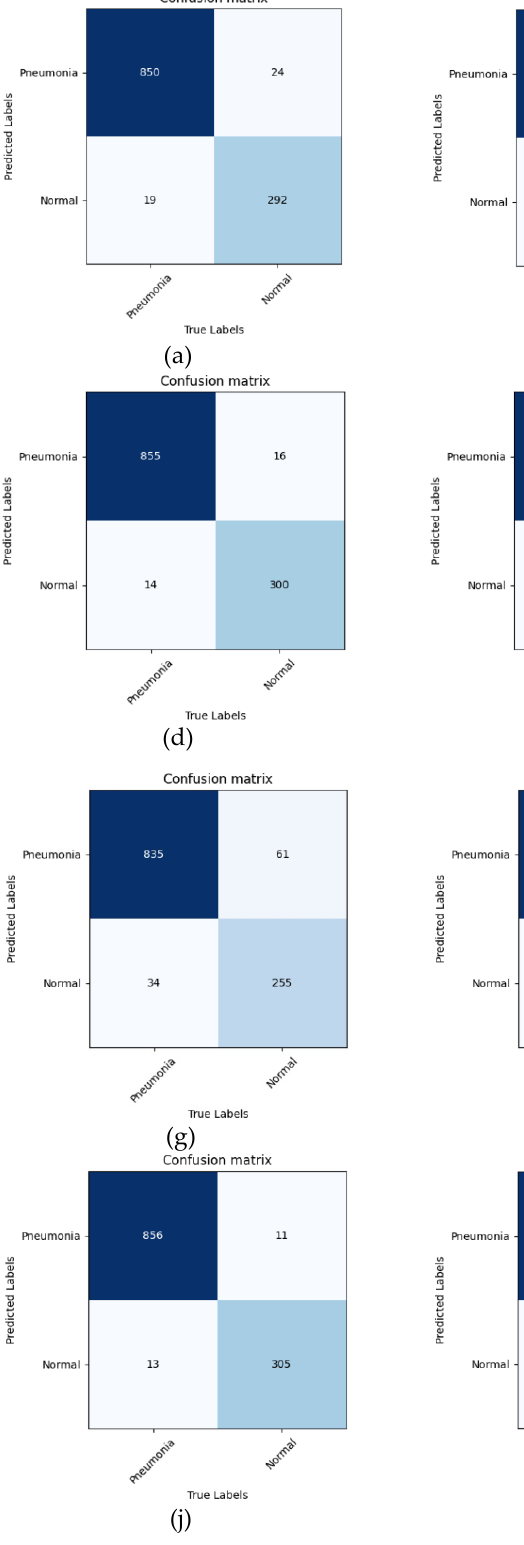
Figure 5. The confusion matrix on the test set of the Coronahack dataset. ( a ) VGG16; ( b ) ResNet50; ( c ) DenseNet121; ( d ) [41]; ( e ) [42]; ( f ) [43]; ( g ) ViT; ( h ) Swin Transformer; ( i ) Uniformer; ( j ) AlterNet; (k) BoT-ViTNet.